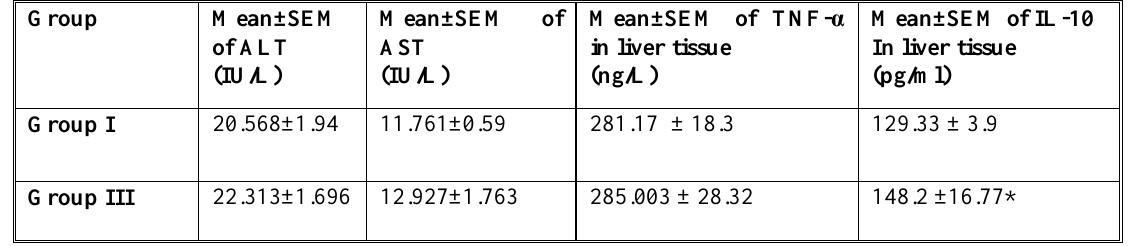
Table 2. Effects of omega-three (ω-3) fatty acids alone on the liver tissue liver tissue enzymes (ALT and AST) and cytokines (TNF-α, IL-10) levels in male rats. (N=7).